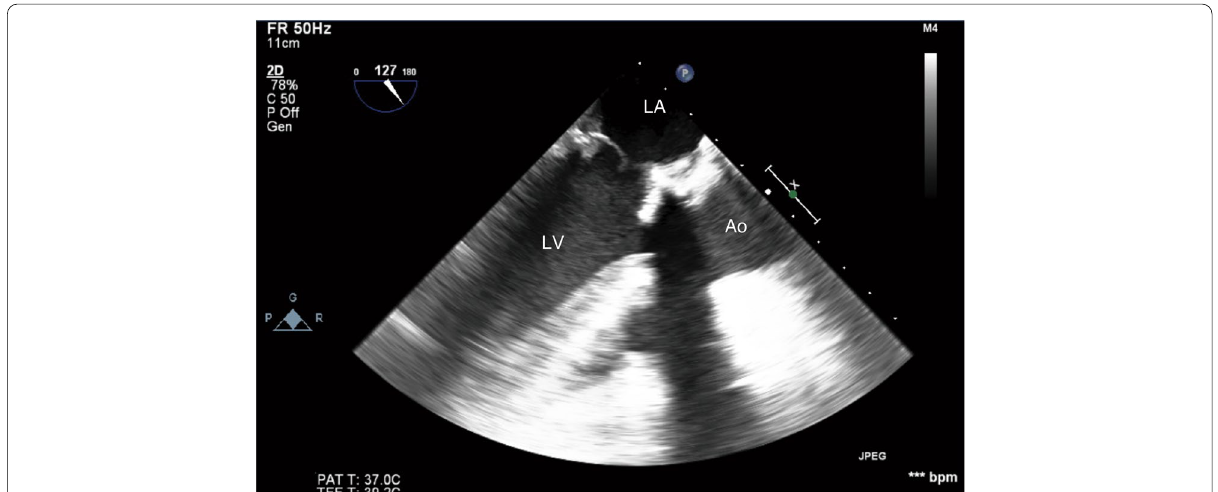
Fig. 5 Mid-esophageal long axis view in the ICU on postoperative day 8. There was no evidence of thrombus formation. Ao, ascending aorta; LA, left atrium; LV, left